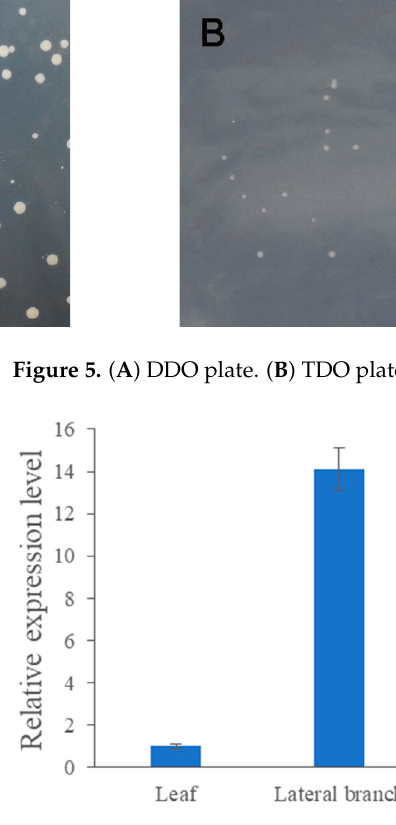
Figure 6. Expression-level analysis of CmRAX2 in ‘Jinba’. The lines are used to show standard errors.